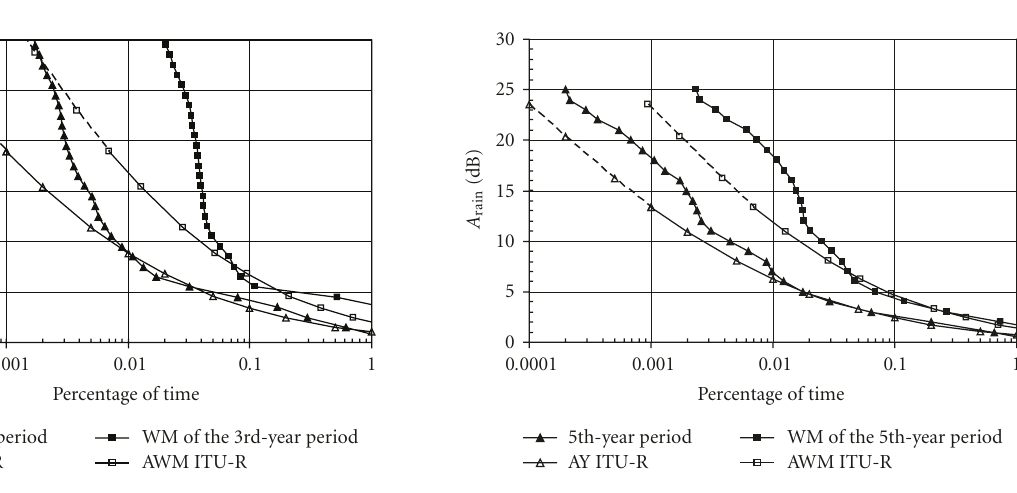
Figure 11: CDs of rain attenuation obtained for the fourth-year period.